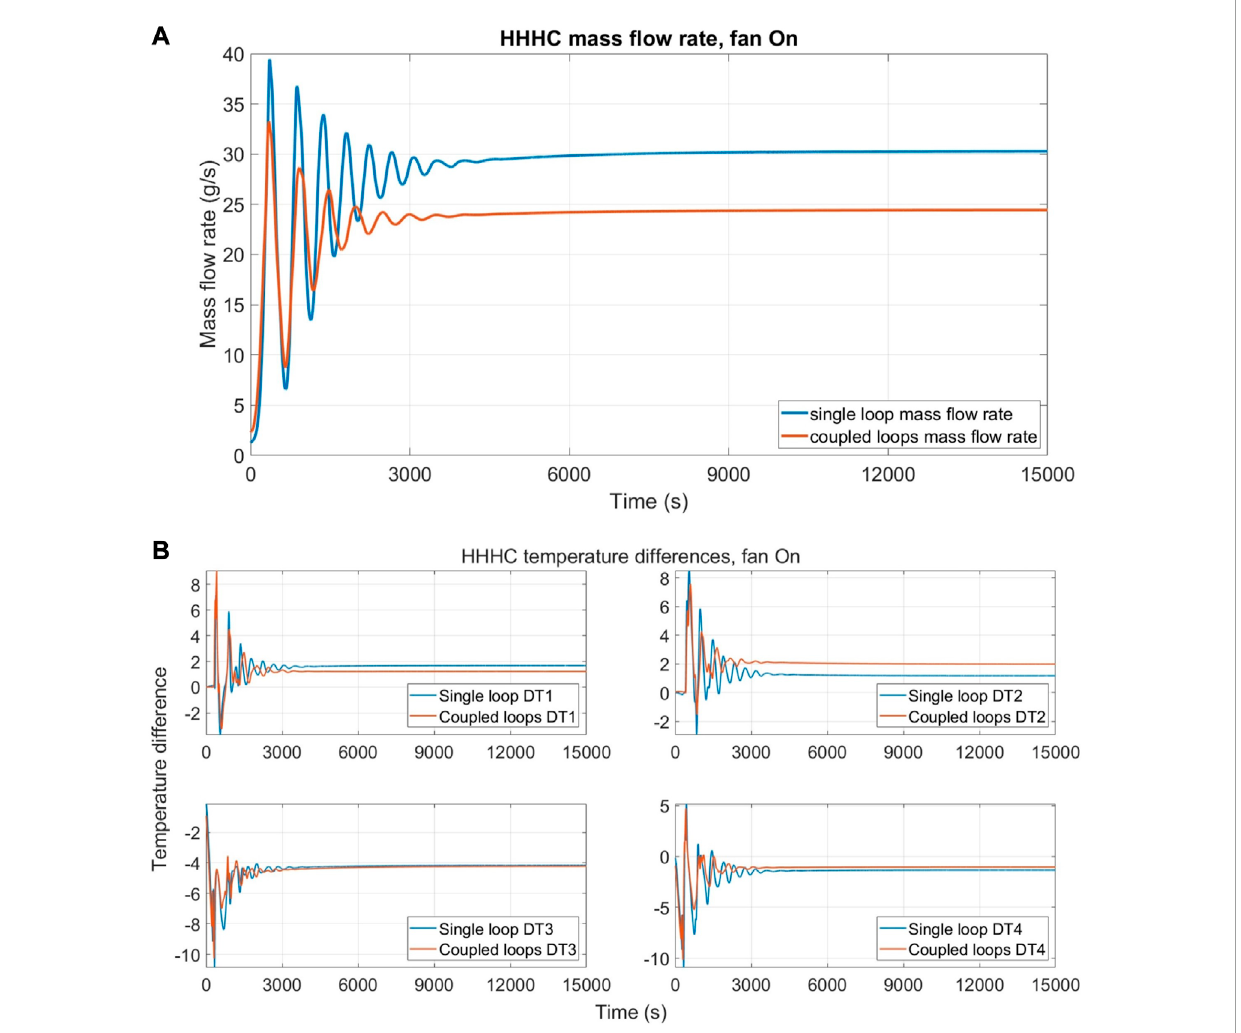
FIGURE 11 Comparison between single DYNASTY and coupled loop simulations with 25% fan speed for HHHC configuration; (A) mass flow rate evolution and (B) temperature difference evolution.